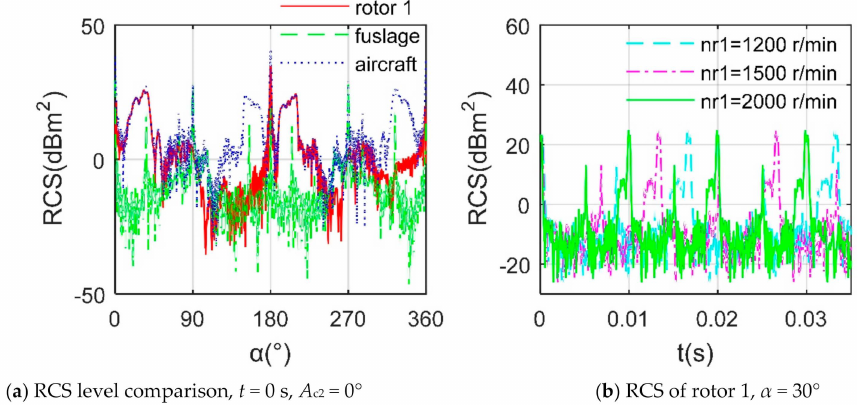
Figure 7. RCS curves of different components, A c1 = 0 ◦ , f rh = 10 GHz. ( a ) RCS level comparison, t = 0 s, A c2 = 0 ◦ . ( b ) RCS curves of rotor 1, α = 30 ◦